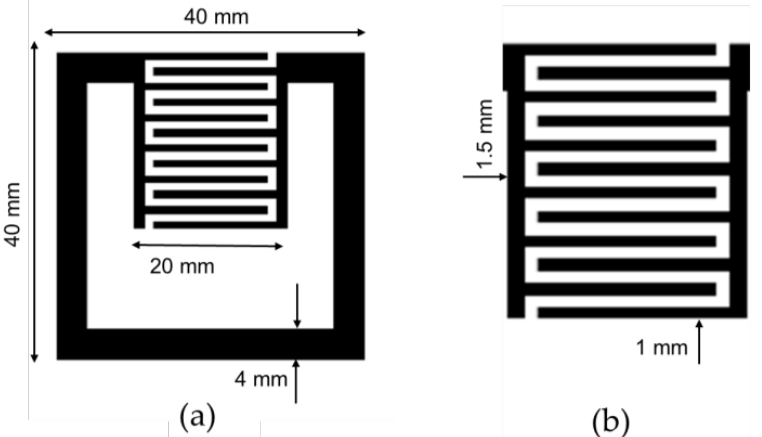
Figure 2. Resonator design. ( a ) Full resonator. ( b ) Detail of the interdigitated structure.